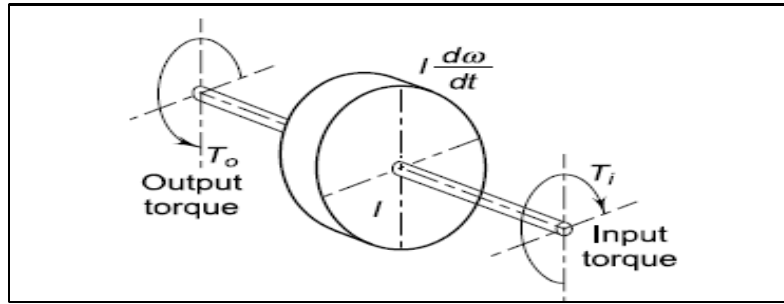
Figure 2. Rotor of synchronous machine.